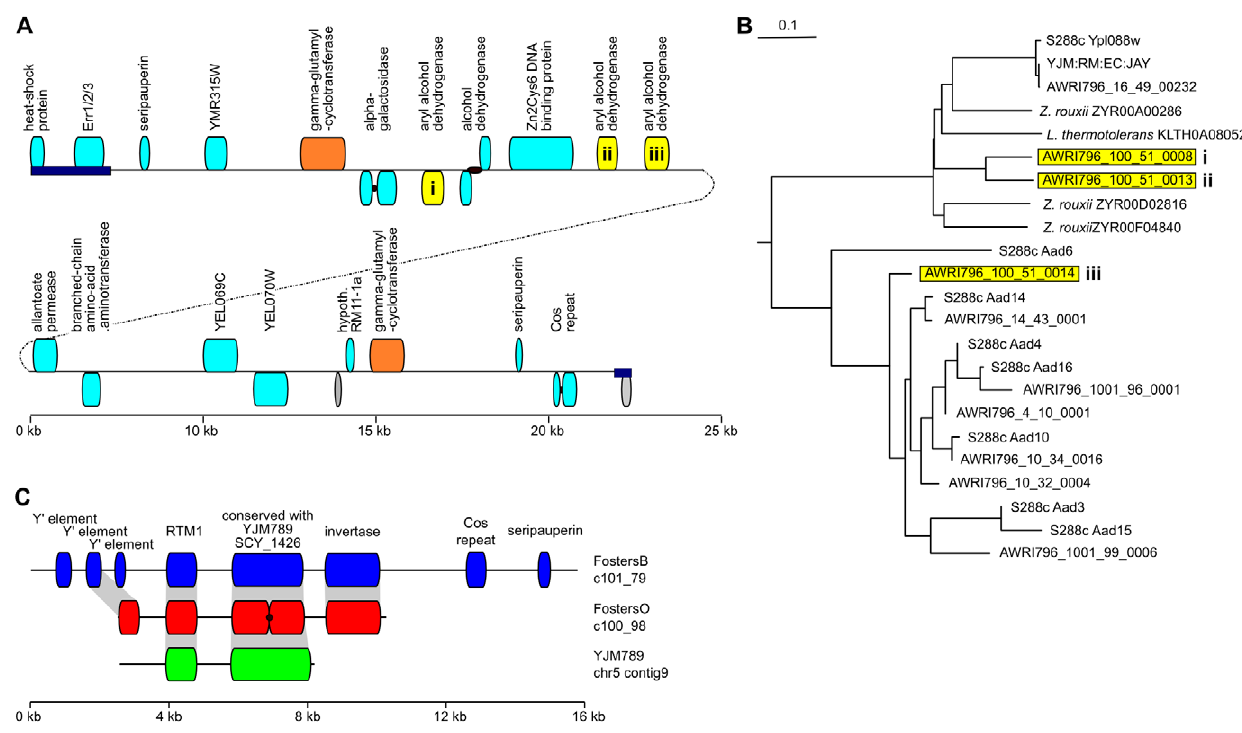
Figure 4. Novel genes found in industrial strains. (A) A 45 kb strain-specific region in AWRI796 which is predicted to encode at least 21 ORFs (full ORF sequences are listed in Dataset S12). ORFs with homology to AADs are highlighted in yellow. The extreme 5 9 and 3 9 ends of this cluster are homologous to a repetitive region present in the sub telomeric regions of chrXIII, XV and XVI (dark blue boxes). Black dots within ORFs represent potential frameshifts in the sequence of these regions. (B) Clustalw dendrogram produced by aligning AAD proteins from S288c, AWRI796 and the top five matches to the highly divergent AWRI796 proteins AAD(i) and AAD(ii). (C) The region in the brewing strains FostersO and FostersB containing RTM1 [22] and the conserved hypothetical ORFs are also found in the human pathogen YJM789 [8].